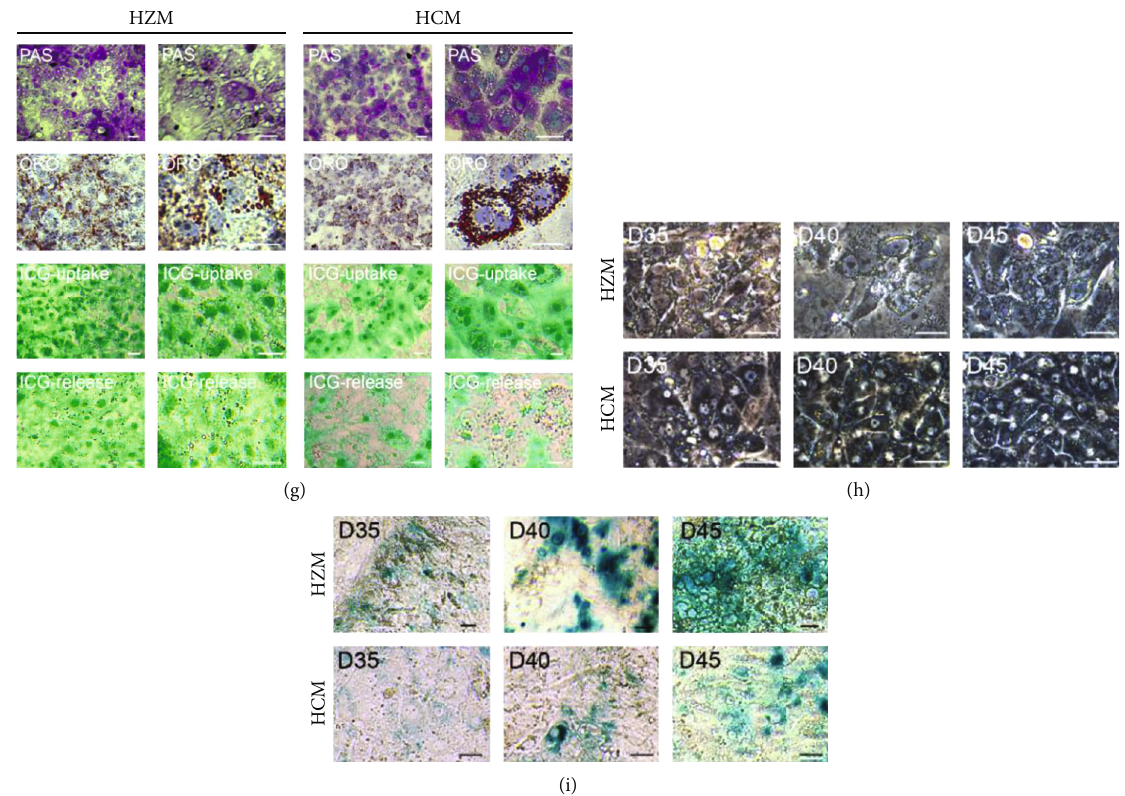
Figure 1: Screening of an optimal culture medium for maintenance of hiPSC-derived hepatocytes. (a) Work fl ow representation of the di ff erentiation procedure. Sequential morphological changes (day 0-25) of hiPSC di ff erentiation into hepatocytes. Scale bars, 50 μ m. (b) Flow cytometry showed the coexpression of NANOG and OCT4 about 97% in day 0 hiPSCs. (c) Immuno fl uorescence showed the coexpression of SSEA4 and OCT4 in the most of day 0 hiPSCs. Scale bars, 50 μ m. (d) Quantitative PCR analysis showed signi fi cantly higher expression of mature hepatocyte markers over di ff erentiation in the HCM group when compared with the HZM group. ∗ p < 0 : 05 , ∗∗ p < 0 : 01 , ∗∗∗ p < 0 : 001 , and n = 3 . (e, f) Immuno fl uorescence showed the coexpression of mature hepatocyte markers in day 30 cells, respectively. Scale bars, 50 μ m. ∗ p < 0 : 05 , ∗∗ p < 0 : 01 , ∗∗∗ p < 0 : 001 , and n = 3 . (g) Hepatocytes performed periodic acid-Schi ff staining (PAS; top), Oil Red O staining (ORO; middle), and indocyanine green uptake/release analysis (ICG; bottom). Scale bars, 25 μ m. (h) Bright fi eld images showed the morphological changes of hepatocytes in HCM and HZM (days 35-45). Scale bars, 25 μ m. (i) Bright fi eld images of senescence β -Gal staining in hepatocytes during days 35-45. Scale bars, 25 μ